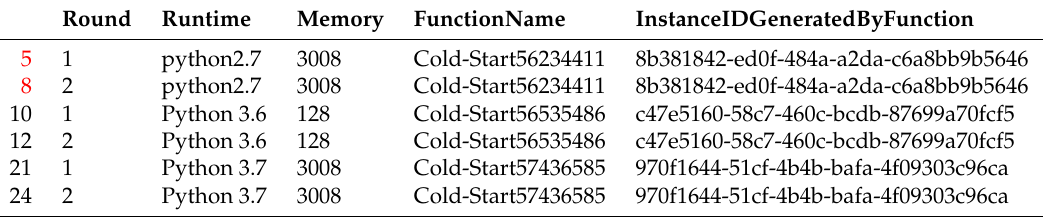
Table 7. Dataset Extract Re-Used VMs—I.